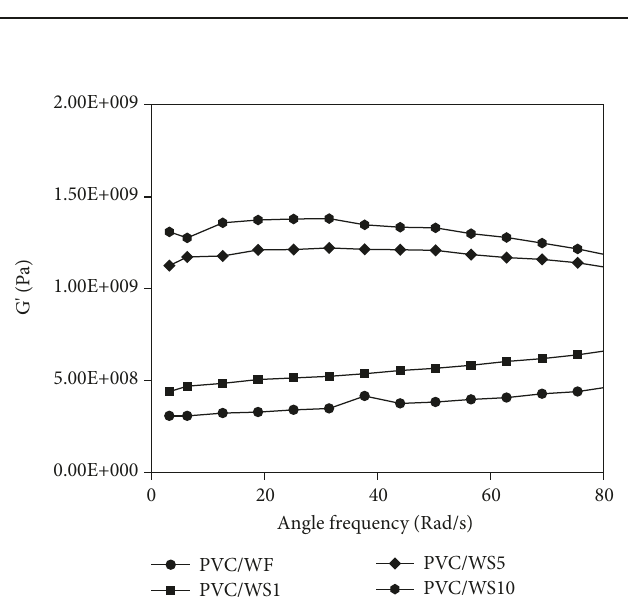
Figure 9: Dynamic storage modulus (G 󸀠 ) of PVC/ WF